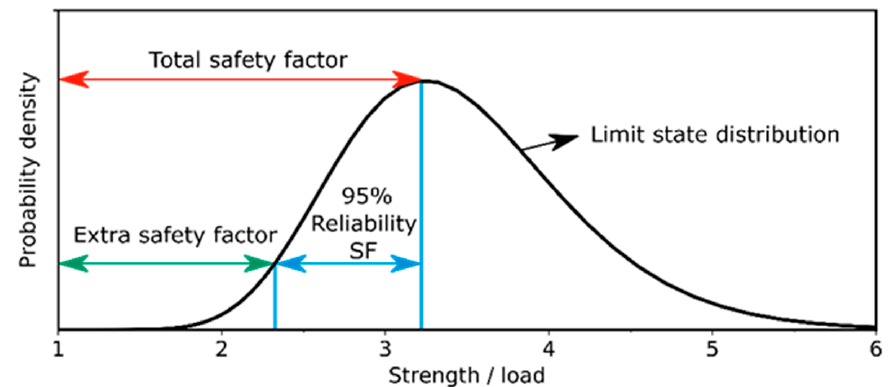
Figure 8. Load–strength limit state function.